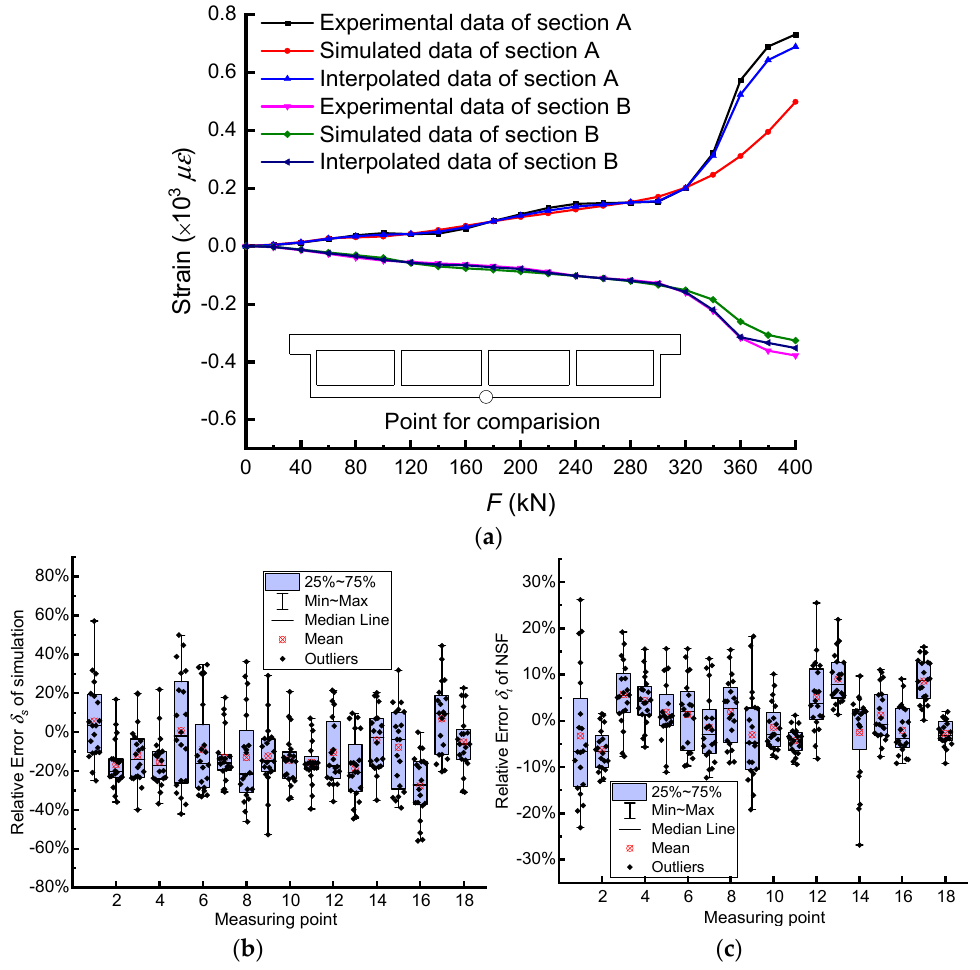
Figure 8. The error comparison between simulated and interpolated data: ( a ) the strain estimation of midpoint by simulation and interpolation, box chart of relative errors of ( b ) simulation, and ( c ) NSF method of section B.